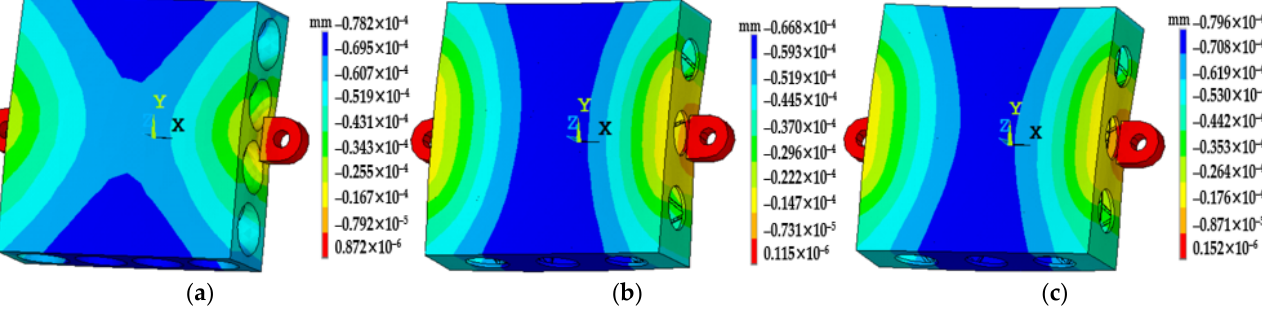
Figure 5. Surface deformations under gravity in Z direction: ( a ) traditional mirror; ( b ) single-layer truss mirror; ( c ) double-layer truss mirror.